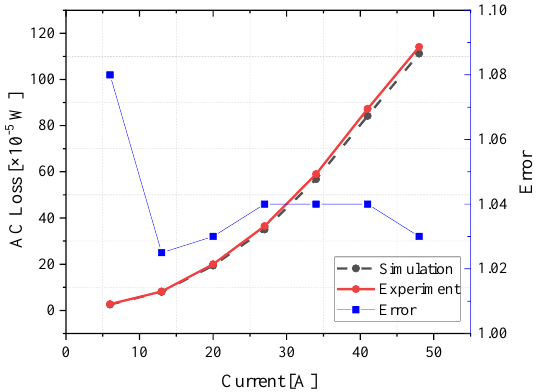
Figure 10. Comparison of AC Losses calculated by simulation and measured by experiment.